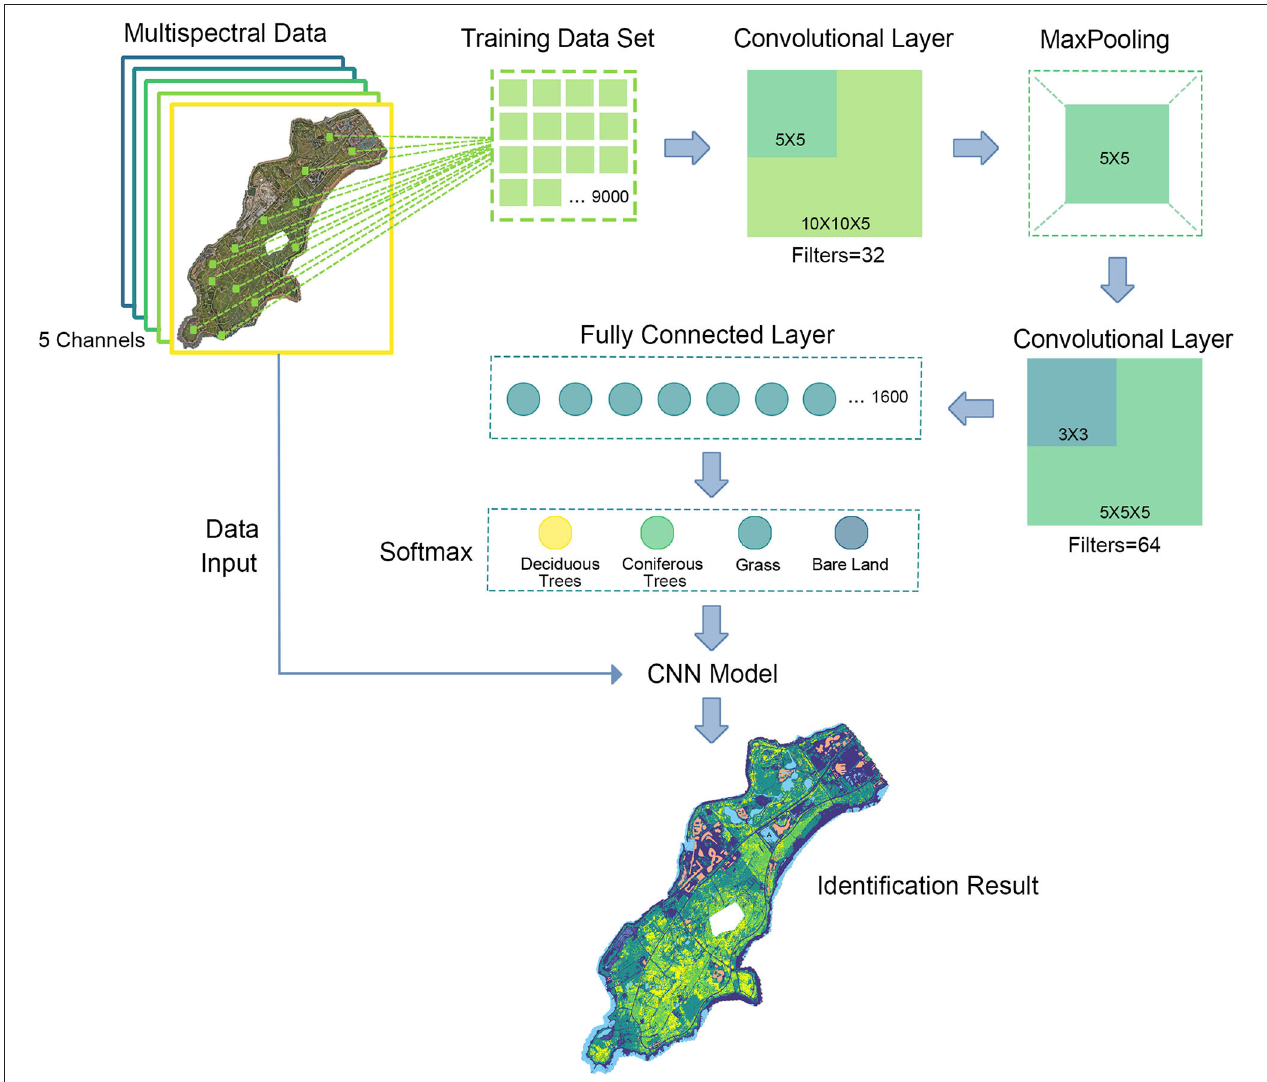
FIGURE 6 | Convolutional Neural Network (CNN) modeling